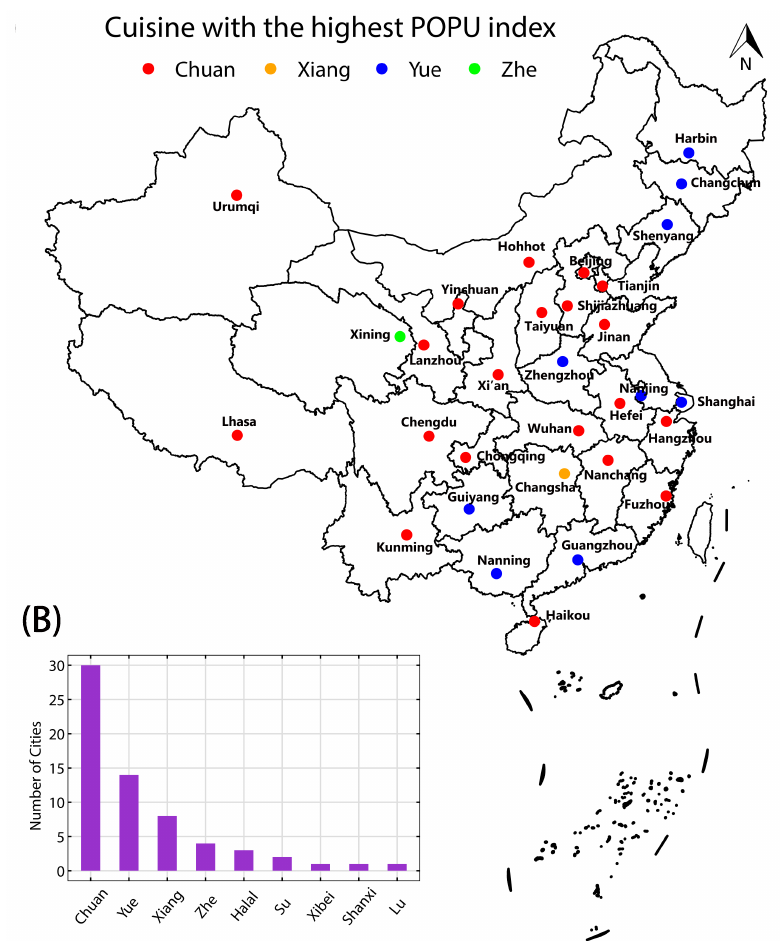
Figure 9. ( A ) Cuisine with the highest POPU value in each city; ( B ) The number of cities where a cuisine is overrepresented among the top-tier restaurants (i.e., with POPU index greater than